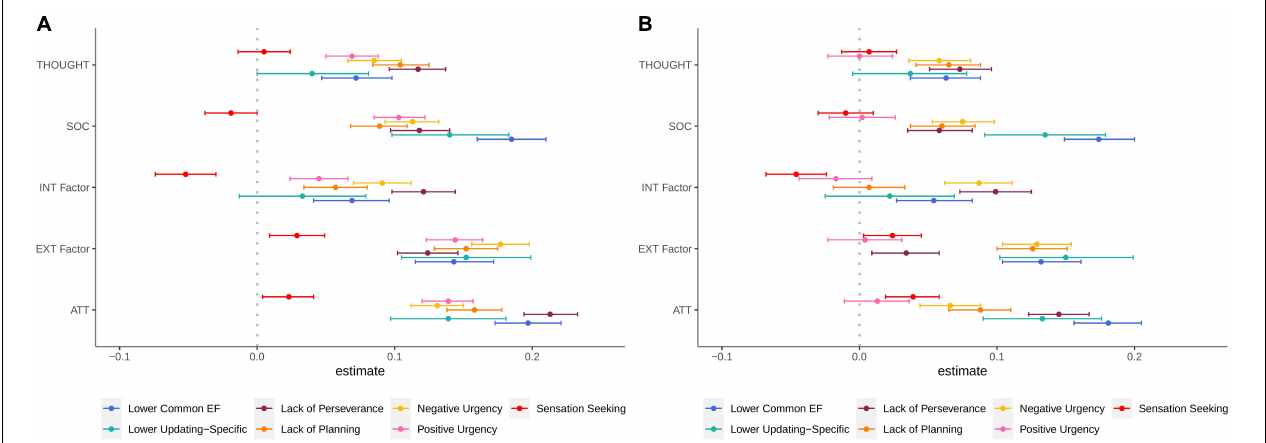
FIGURE 2 | Phenotypic correlations with panel (A) and regression coefficients for panel (B) relationships between EFs, impulsivity, and a correlated factors model of psychopathology. The correlation and regression coefficients estimates are on the X -axis. Psychopathology is on the Y -axis. SOC, social problems; THOUGHT, thought problems; ATT, attention problems; INT Factor, factor with anxious/depressed, withdrawn/depressed, and somatic complaints as indicators; EXT Factor, Externalizing factor with rule-breaking behavior and aggressive behavior as indicators. Color of the lines and dots represent EF factors and impulsivity facets. Error bars are 95% Cls from Mplus. The metric of EF and Updating-Specific was reversed to be in the same metric as impulsivity where higher numbers indicate lower control. N = 11,873. See Supplementary Materials for results of phenotypic models in the twin